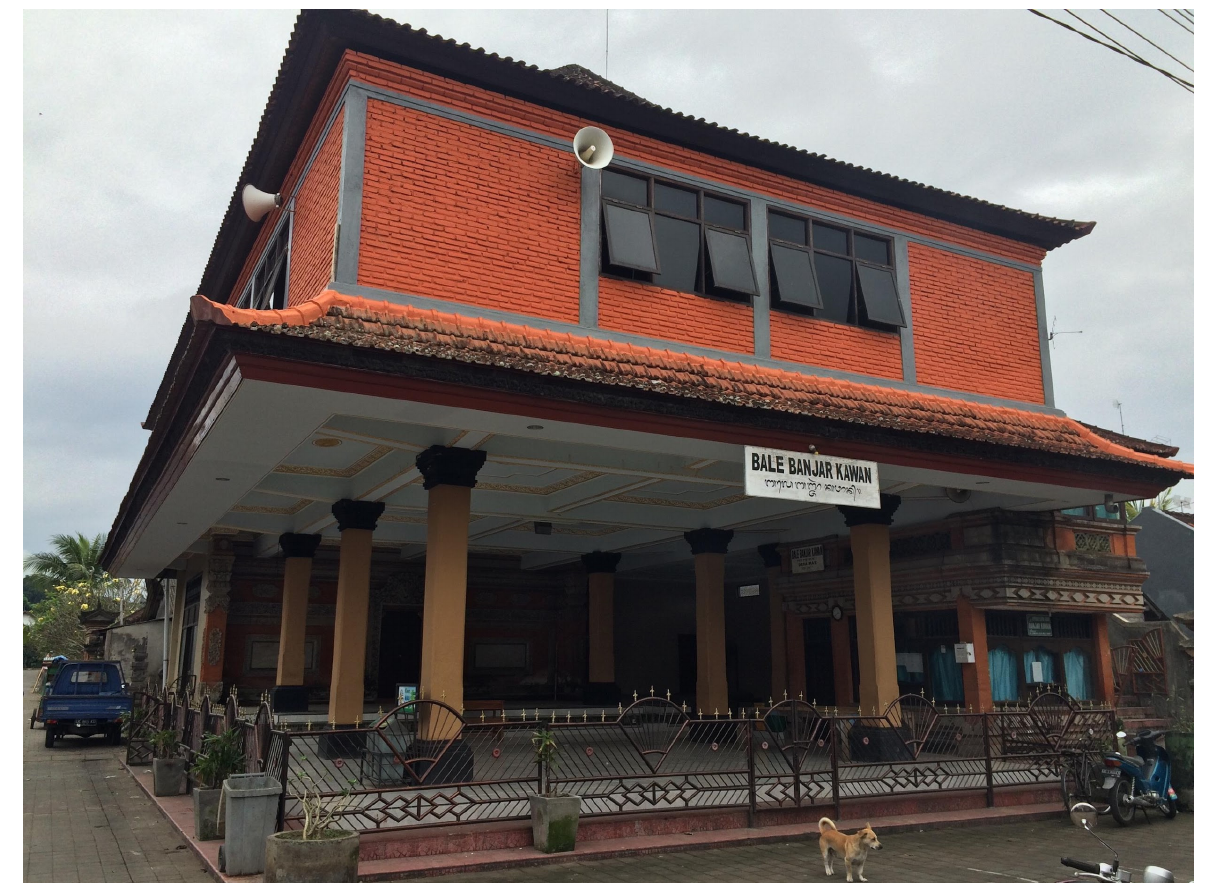
Figure 1. Loudspeaker on the Balinese community meeting hall in Banjar Kawan, Mas, Bali. Photo by the